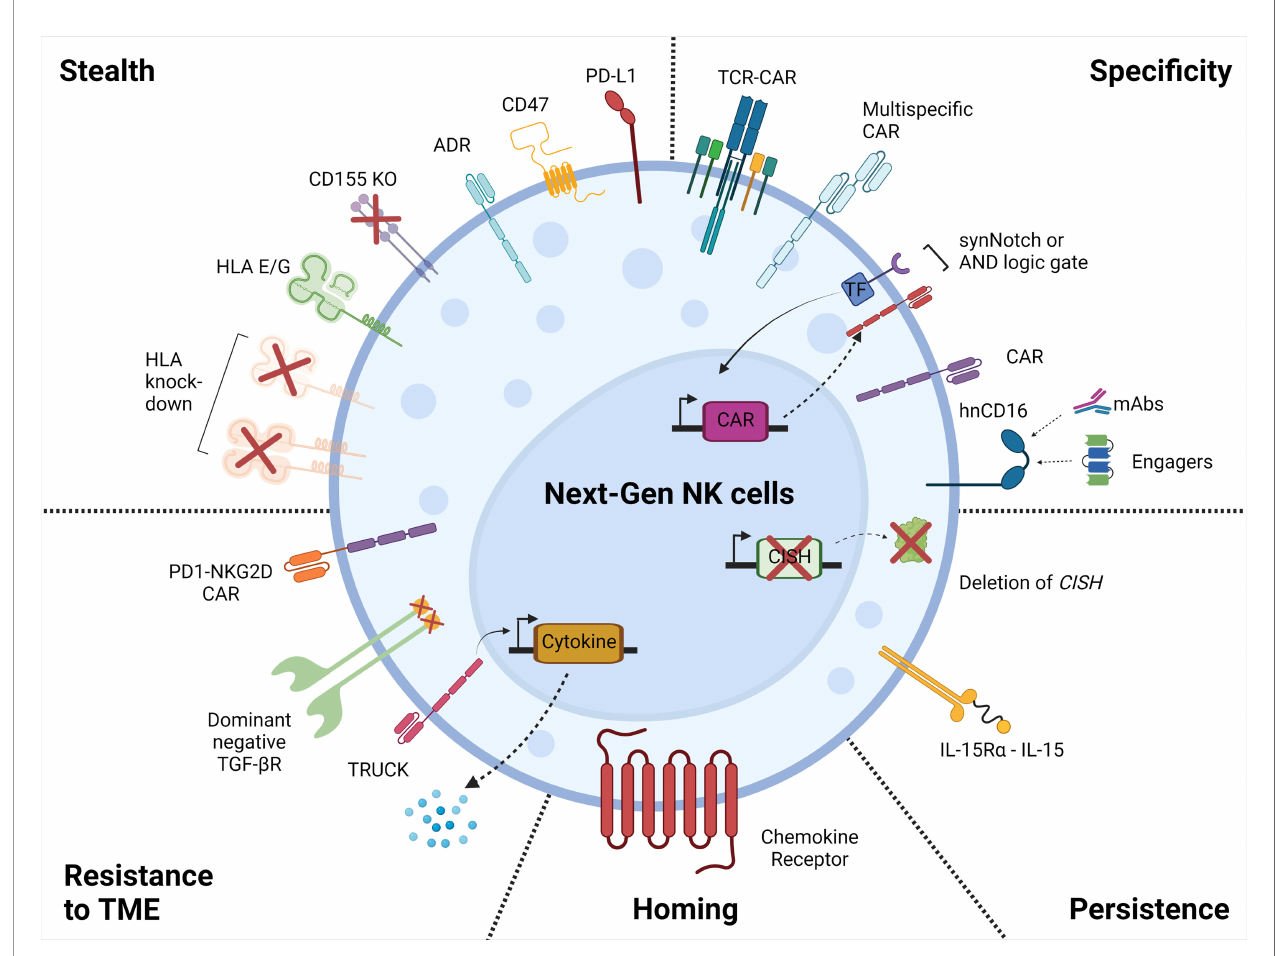
FIGURE 2 | Next generation NK cell products. Illustration of the attributes of the next-generation NK cell products with increased tumor-targeting speci fi city, persistence, homing, resistance to the tumor microenvironment, and with stealth capabilities. This fi gure was created using